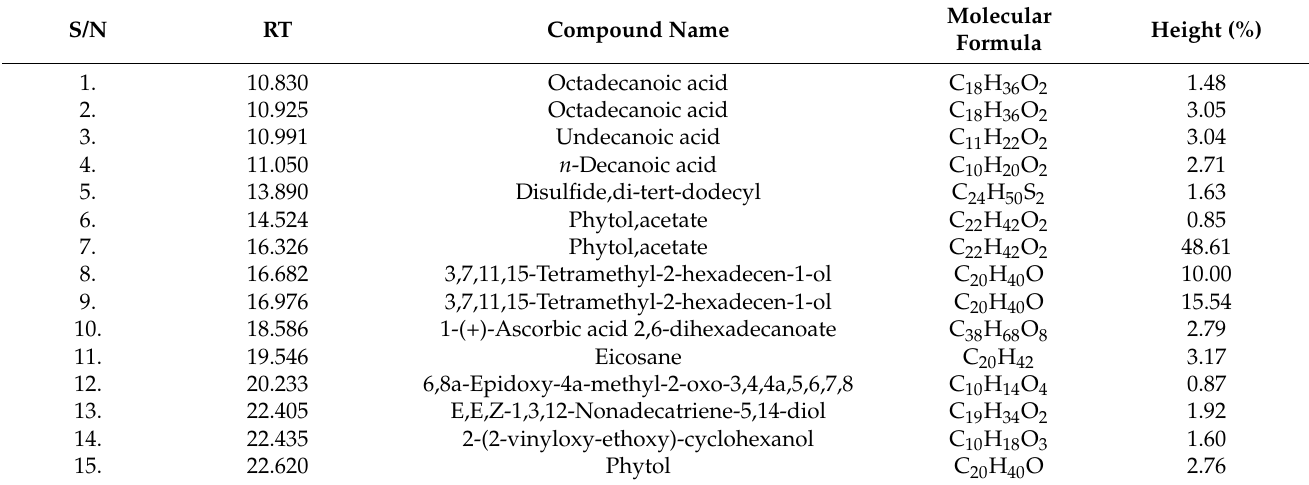
Table 4. Compounds found in the chloroform extracts of D. villosa stem by GC–MS analysis.